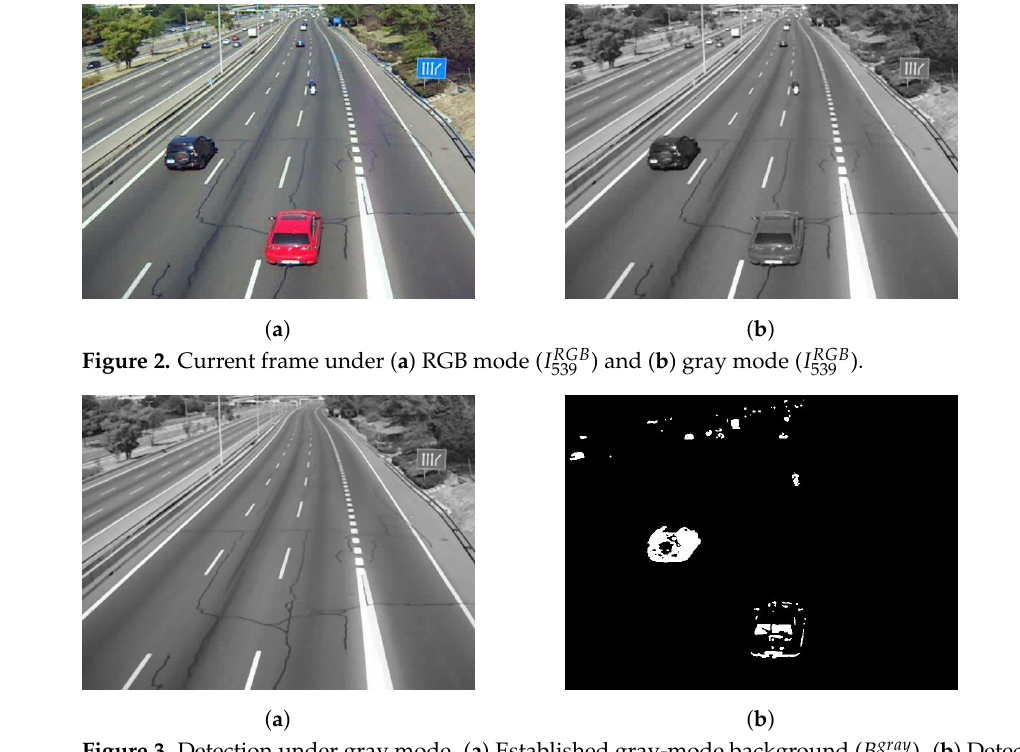
Figure 3. Detection under gray mode. ( a ) Established gray-mode background ( B gray ). ( b ) Detection binary gray result under gray mode ( I ). 539